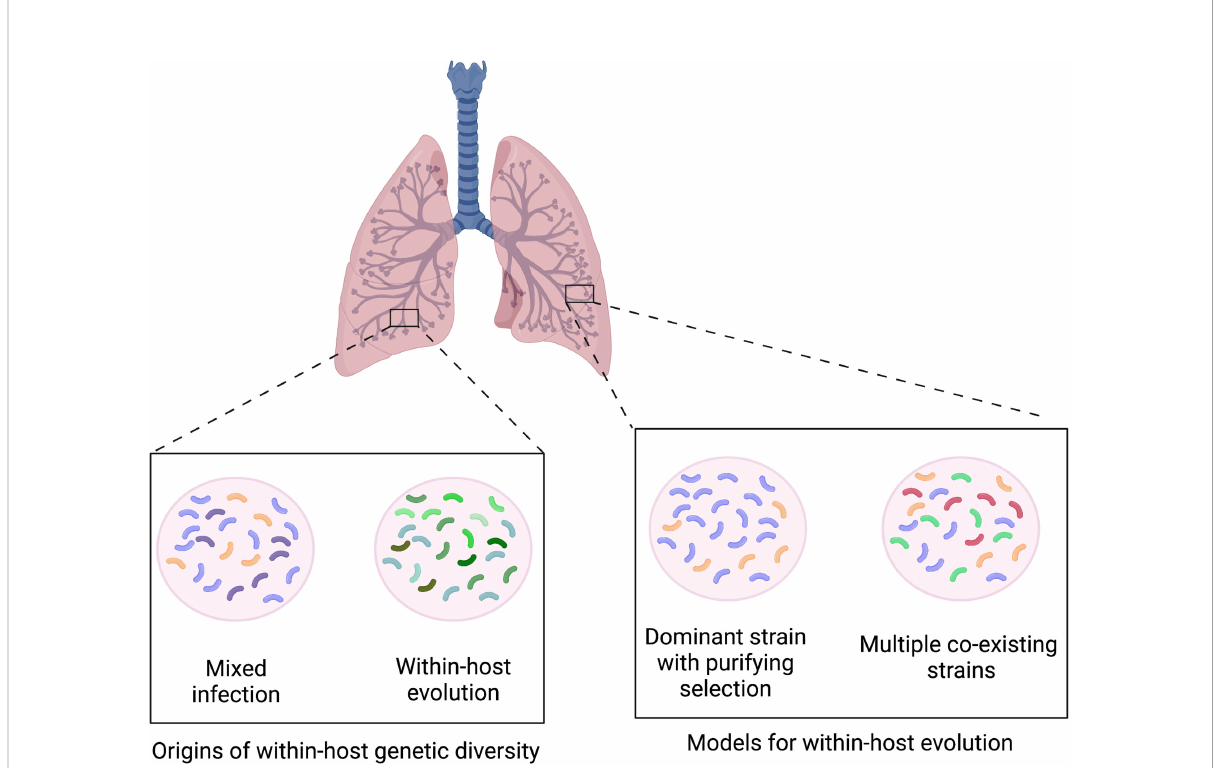
FIGURE 3 Infection model showing how within-host genetic diversity may occur through mixed infection with genetically different strains or within-host evolution of a clonal infecting strain. Model of within-host evolution showing single dominant strain, with purifying selection leading to loss of variants with reduced fi tness and multiple co-existing strains within